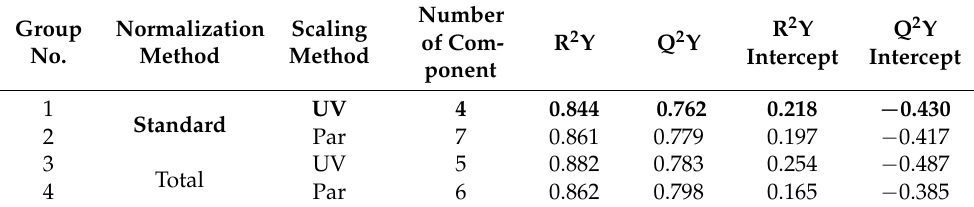
Table 2. Parameters of orthogonal partial least squares-discriminant analysis (OPLS-DA) models based on various normalization and scaling methods to discriminate between Korean and Chinese soybean